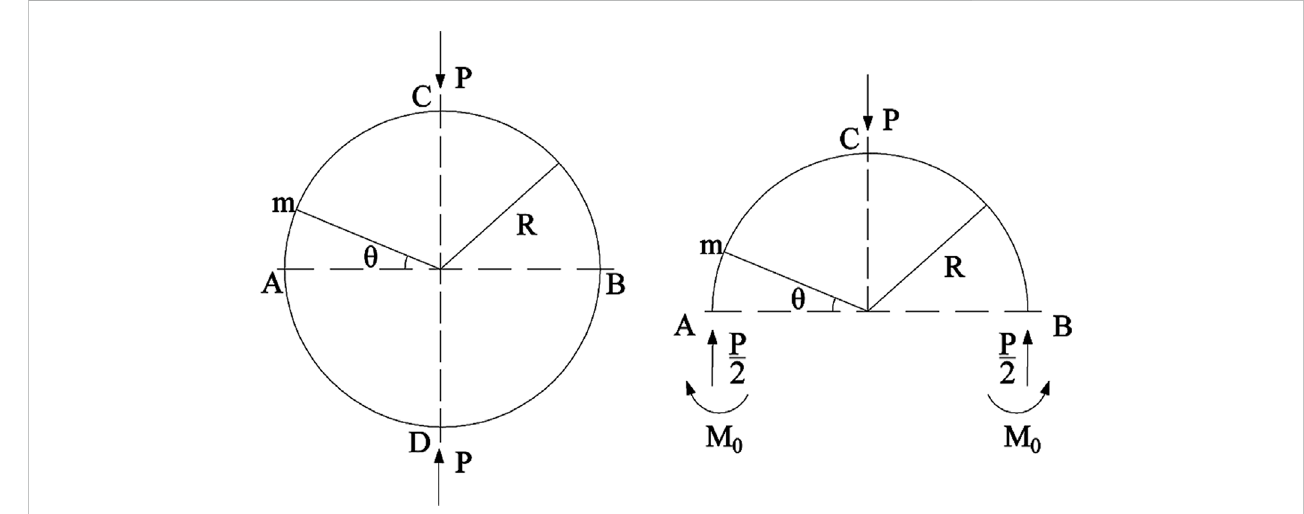
FIGURE 2 Ring under a symmetrical radial compression load.